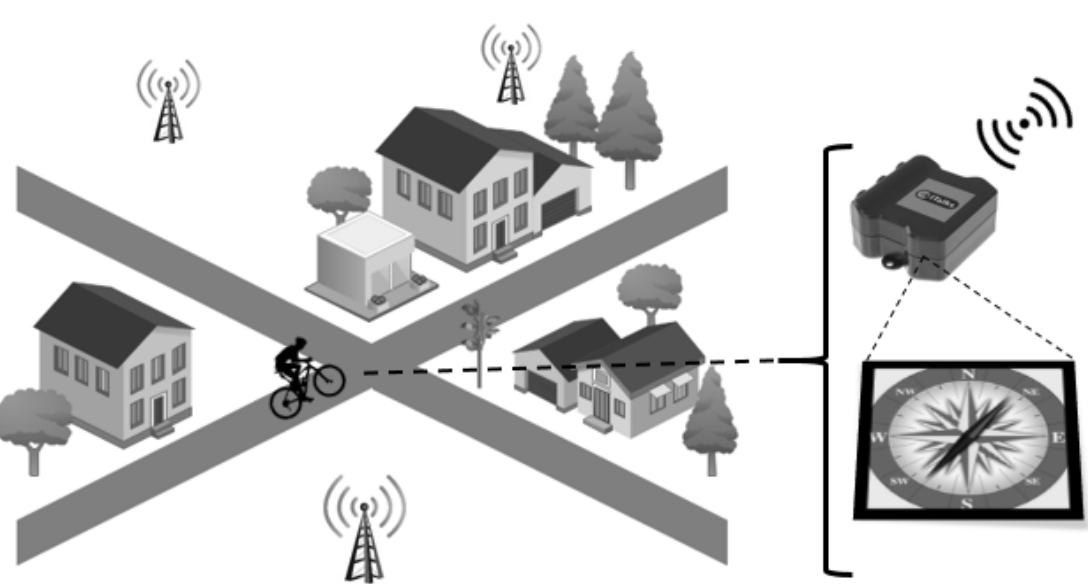
Figure 1. Measurement environment where a LoRaWAN node is attached to a bicycle. The node transmits the e-compass directional data to the network and the Time of Arrival is recorded on all